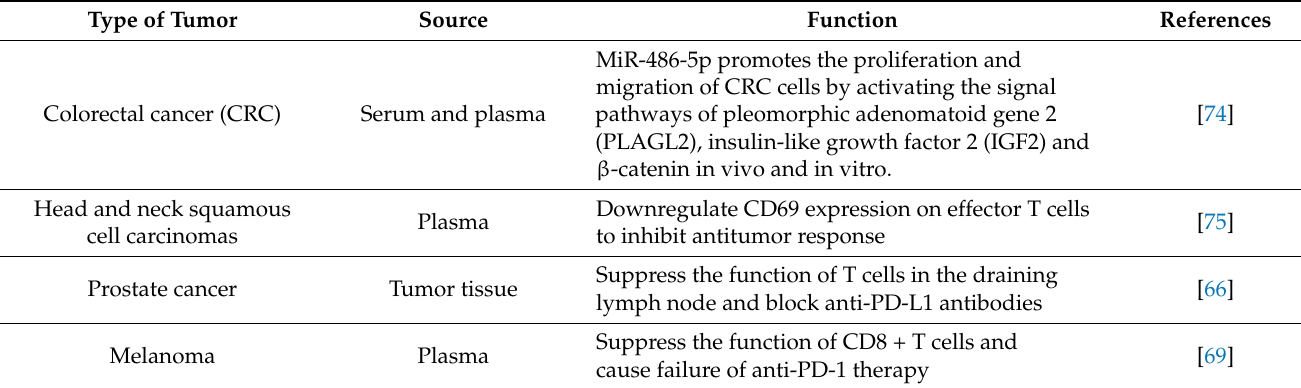
Table 1. Function of exosomal PD-L1 in tumor